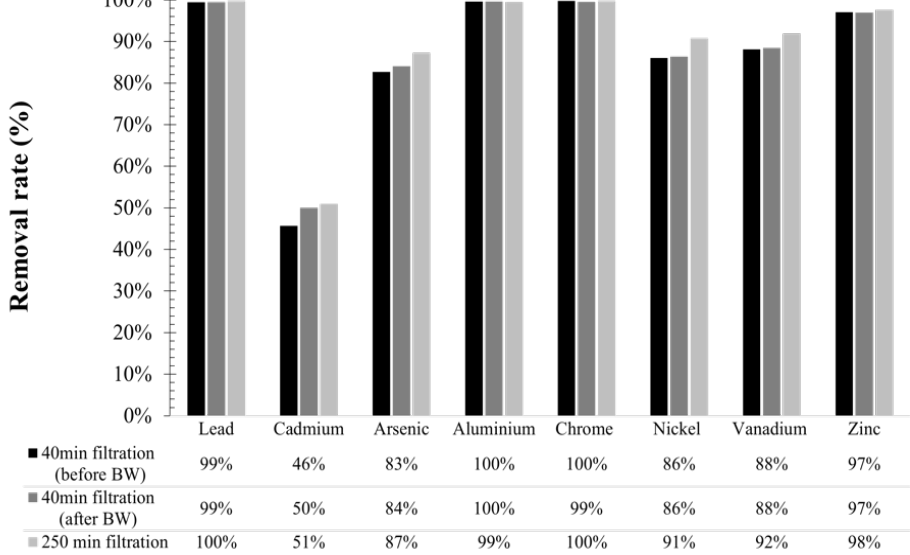
Figure 15. Heavy metal retention and impact of BW action for high-fouling water.